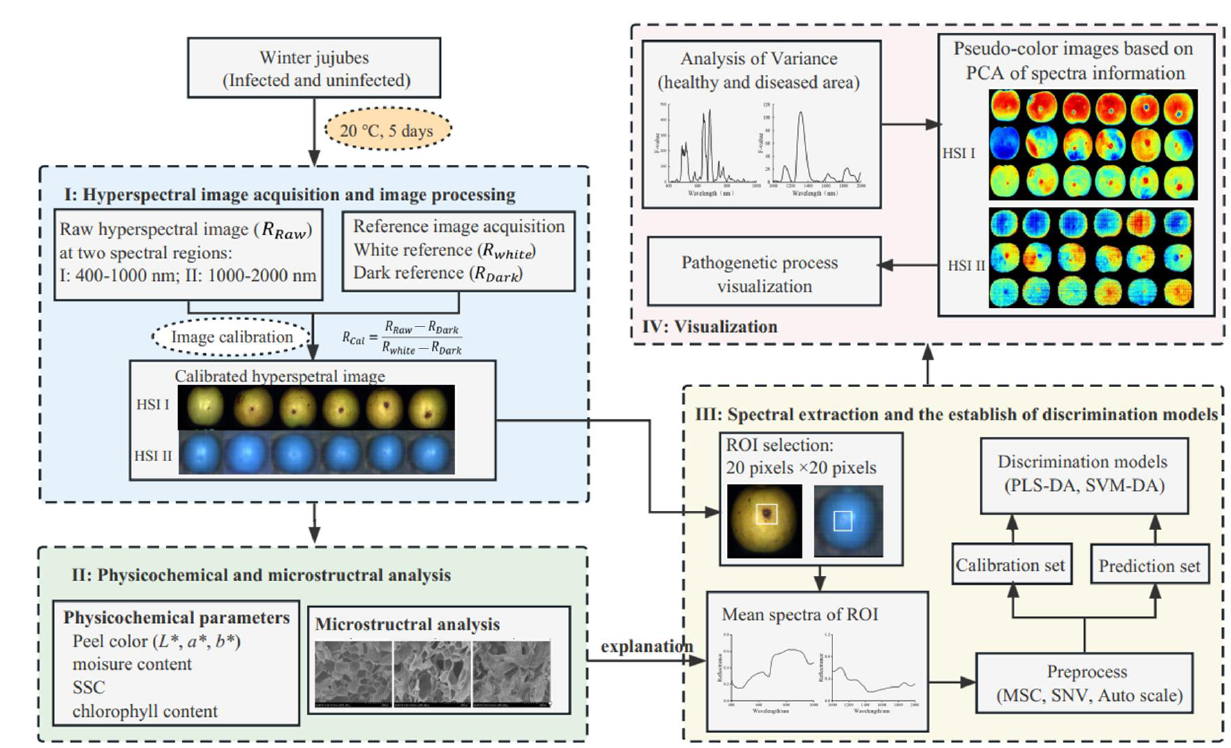
Figure 1. Procedures for black spot disease detection and pathogenetic process monitoring on winter jujube fruit using the HSI system in two spectral regions. ( L* : lightness (0 = dark, 100 = light); a* : greenness (−)/redness (+); b* : blueness ( − )/yellowness (+); SSC: soluble solids content; ROI: region of interest; PLS-DA: partial least squares discrimination analysis; SVM-DA: support vector machine discrimination analysis; PCA: principal component analysis).